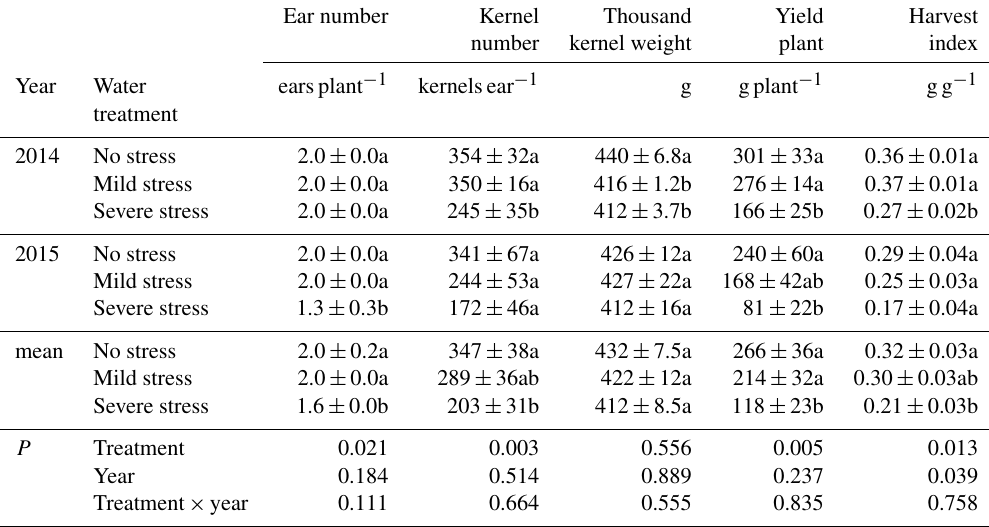
Table 2. Yield and yield components affected by different water stress from 2014 to 2015. Ear number Kernel Thousand Yield Harvest number kernel weight plant index